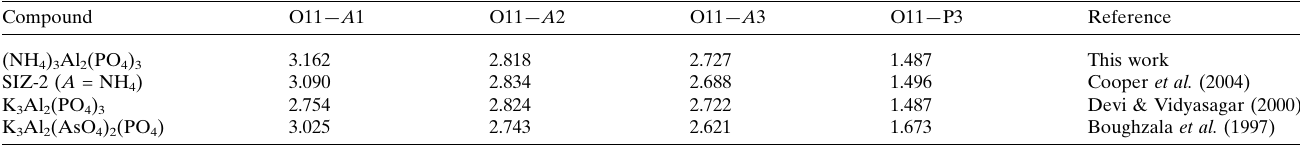
Table 2 Key atomic distances (A˚ ) in related A 3 Al 2 (PO 4 ) 3